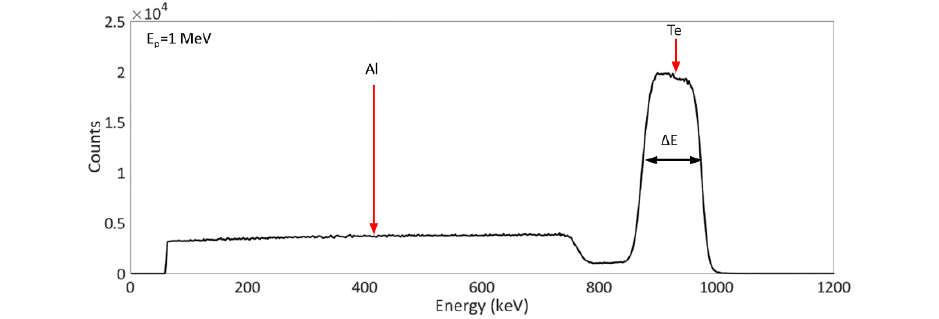
Fig.1. A typical spectrum of the proton